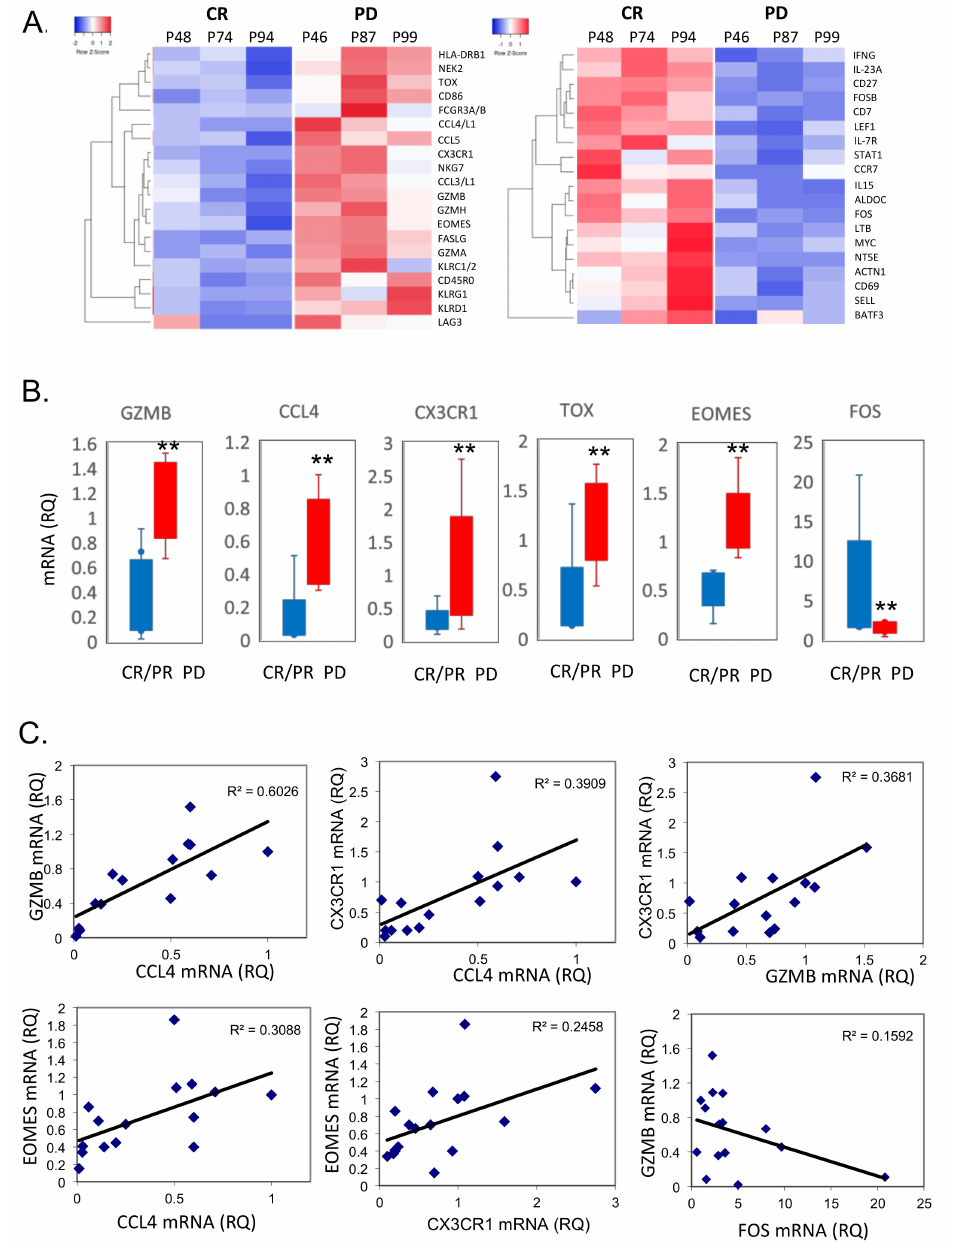
Figure 3. Transcriptional profiles of CAR T cellular products reveal T cell-intrinsic quality attributes associated with clinical response. ( A ) Genes differentially expressed in CAR T cells from patients with complete response (CR) and a low frequency of phenotypically exhausted (CD28 - CD57 + CD39 + ) CD8 + cells ( n = 3) and CAR T cells from patients with progressive disease (PD) and a high frequency of exhausted CD8 + T cells ( n = 3). RNA was isolated, and gene expression analysis was performed using the nCounter ® CAR-T Characterization Gene Expression Panel (Nanostring). Heat maps show log2-fold gene expression changes (false discovery rate values, 0.01) in CR vs. PD subsets. Each column depicts an individual sample, and each row represents an individual gene, shaded to indicate normalized expression. ( B ) Real-time PCR analysis of relative mRNA expression of GZMB , CCL4 , CX3CR1 , TOX , EOMES and FOS in CAR-T cells from patients with CR ( n = 9) and PD ( n = 6), ** p < 0.001. ( C ) Spearman’s rho correlation (two-tailed) between the mRNA expression levels of GZMB and CCL4 , CX3CR1 and CCL4 , CXC3CR1 and GZMB , EOMES and CCL4 , EOMES and CX3CR1 , and GZMB and FOS in CAR T cells ( n =